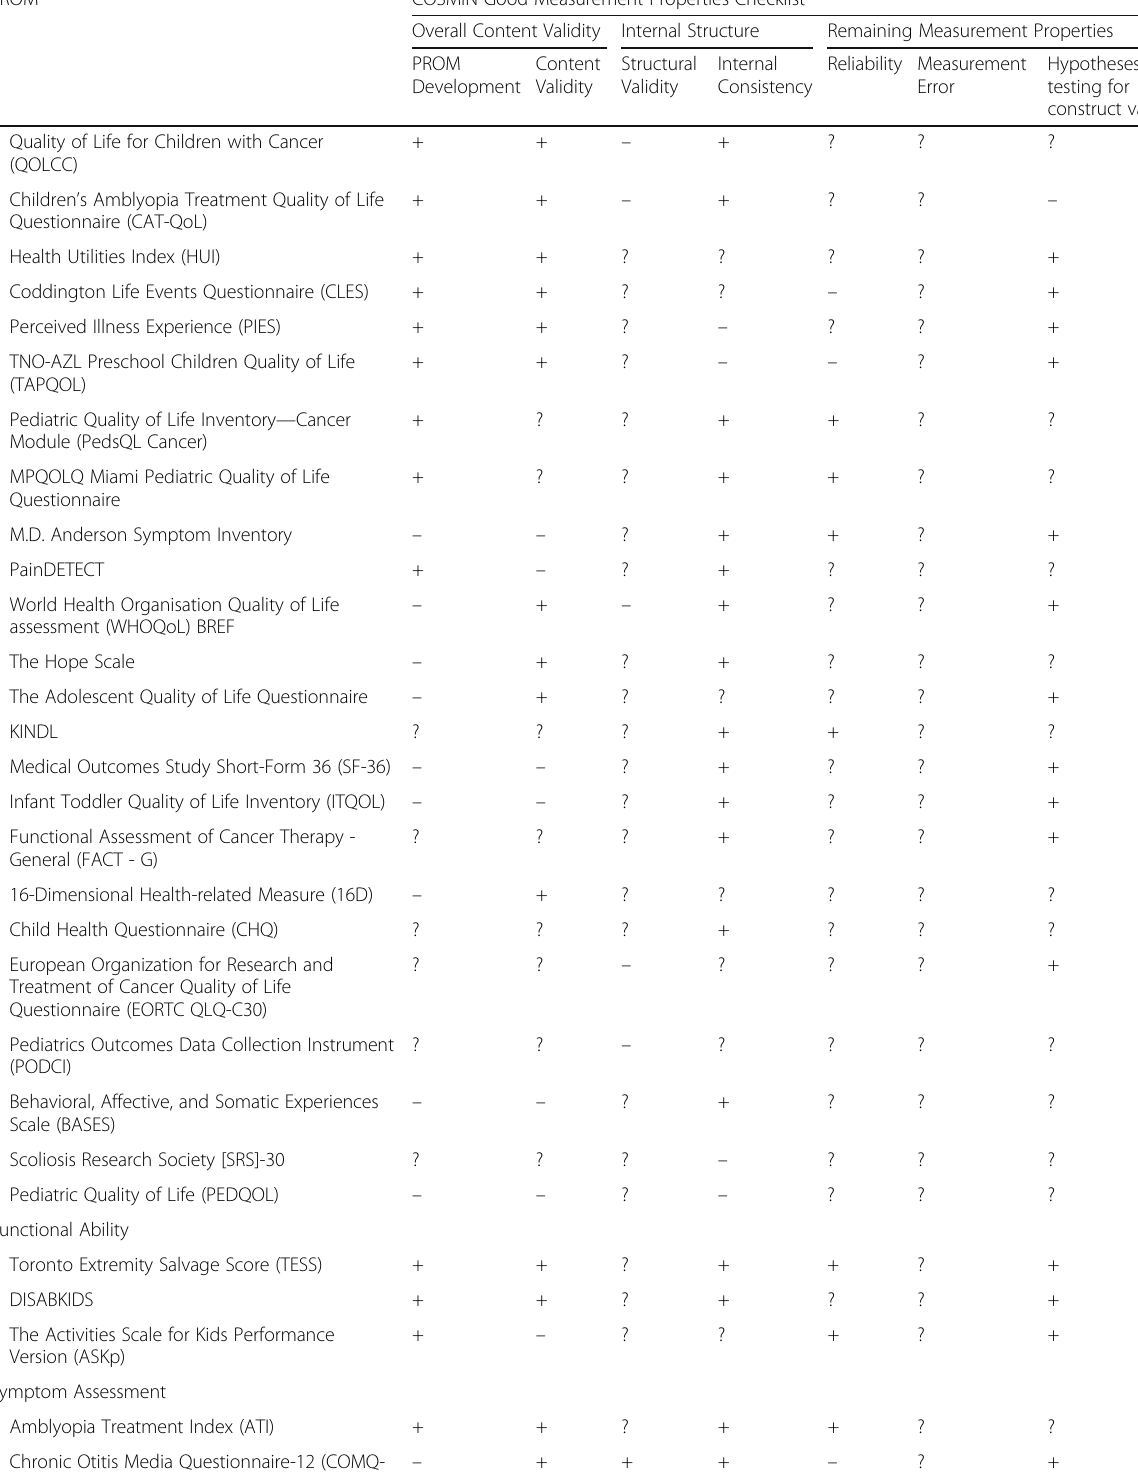
Table 1 Quality analysis of all identified PROMs ( n = 100). The COSMIN ‘ good property checklist ’ was applied on 100 PROMs, across 7 measurement properties stratified by construct. PROMs were ranked highest score of sufficient quality to lowest, within a construct. ‘ + ’ indicates a score of sufficient quality, ‘ ? ’ indicates that the specific measurement property was not reported on, and ‘ - ’